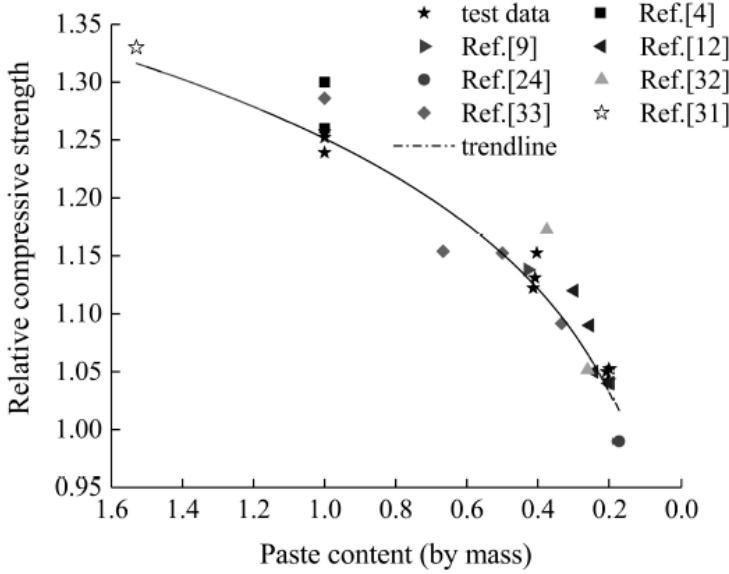
Figure 10. Relative compressive strength versus mass fraction of paste. ( (cid:73) represents the data from molecular simulation of C–S–H. C–S–H accounts for 60%~70% of hydration products, here it takes the middle value of 65%. So preparing a unit mass of C–S–H requires 1.54 unit mass of cement